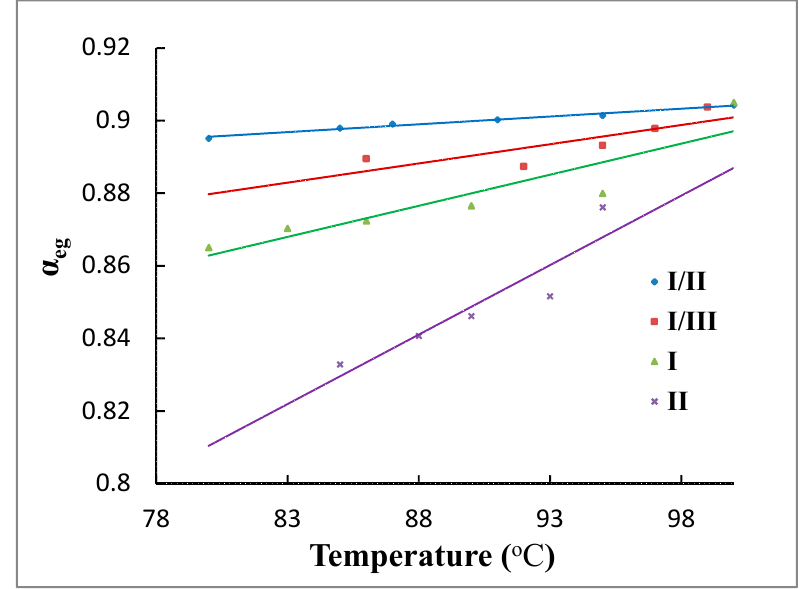
Figure 10. Effective geometry parameter α eg for materials ( I , II , I/II and I/III ) varies with temperatures.